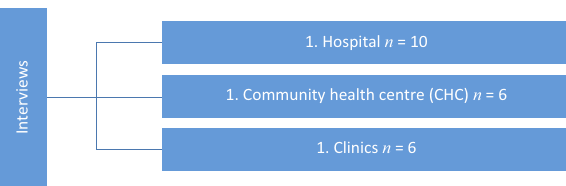
FIGURE 1: Number of participants in each